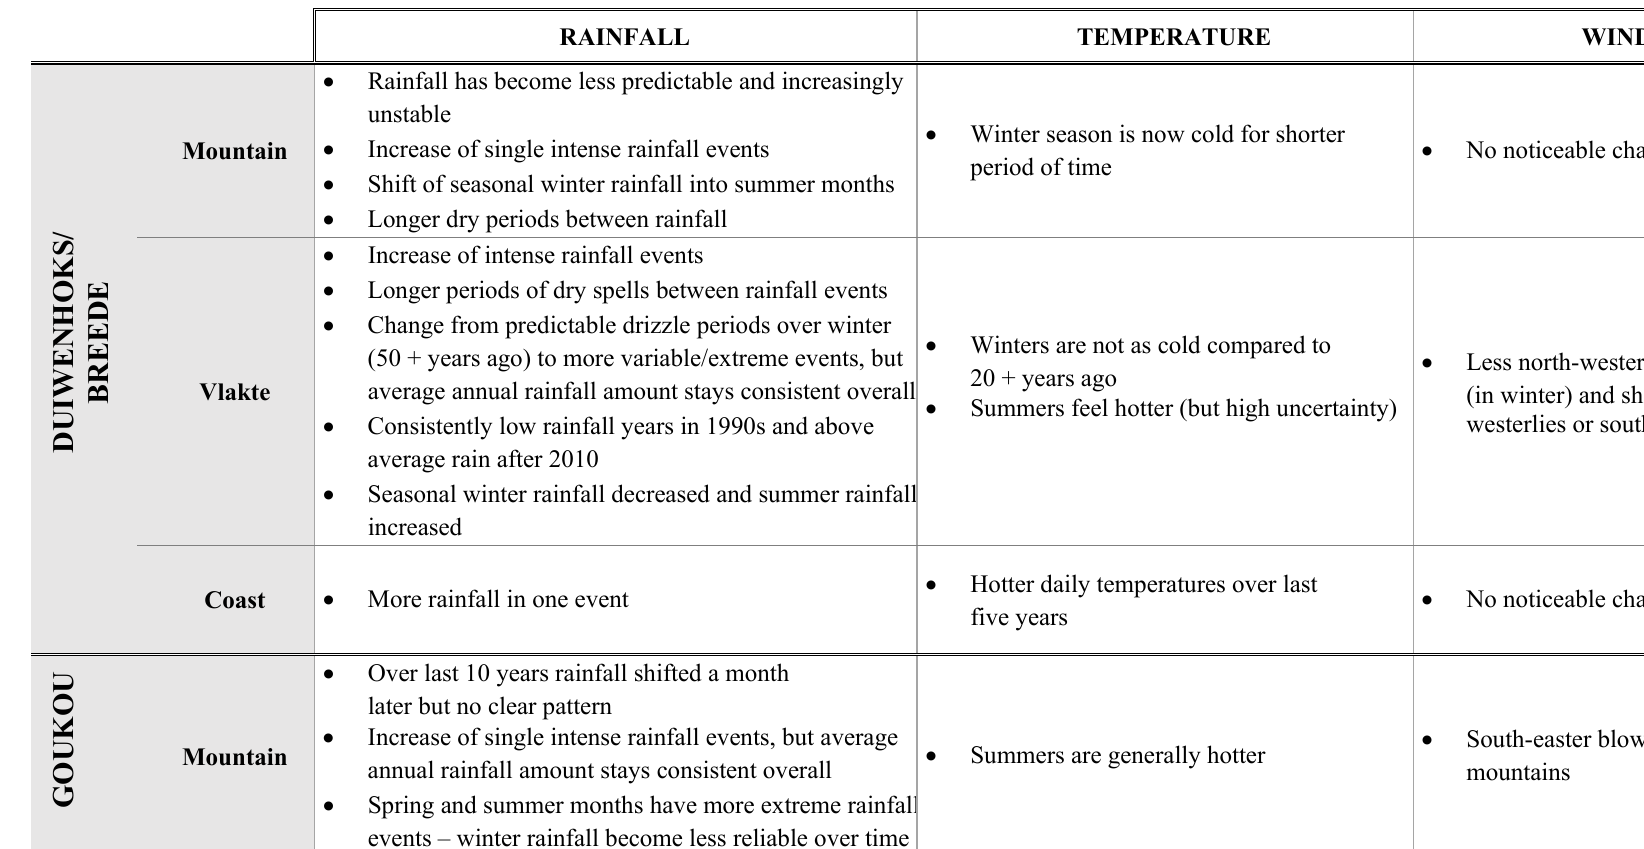
Table A2 .1 : Farmers’ observed change in weather patterns over time grouped according to area (i.e., mountain, vlakte and coast) within catchment (i.e., Duiwenhoks/Breede; Goukou and